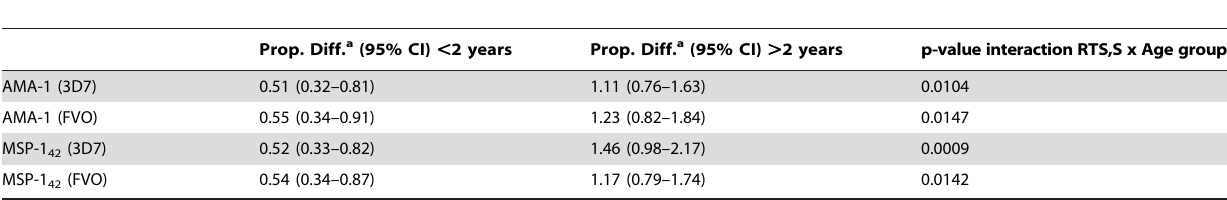
Table 2. F-test for interactions between RTS,S vaccine group and key variables on antibody